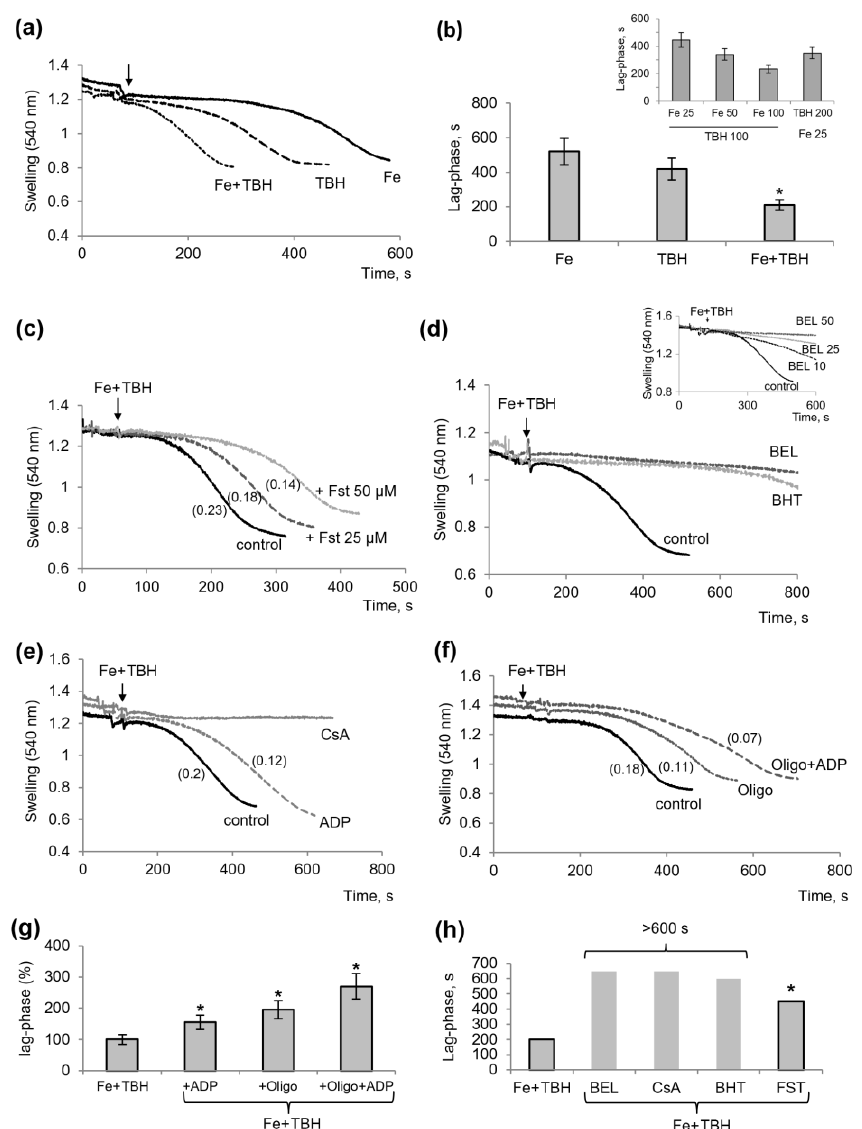
Figure 1. Induction of the mitochondrial swelling by TBH and ferrous ions. Influence of inhibitors of the lipid peroxidation and MPTP opening. Influence of TBH (100 µ M), FeCl 2 (50 µ M) on the swelling induction ( a ) and the lag phase at their different concentrations ( b and insert); the protective influence of ferrostatin (FST) ( c ), BEL (50 µ M), BHT (20 µ M), and BEL at different concentrations ( d , insert), ADP and CsA I, and oligomycin (1.5 µ M) ( e , f ) on the induced swelling. Influence of inhibitors on the pre-swelling time (lag-phase) ( g , h ). The swelling rate ( ∆ /min) is indicated in parentheses. An asterisk (*) indicates values that differ significantly from the control values ( p < 0.05).